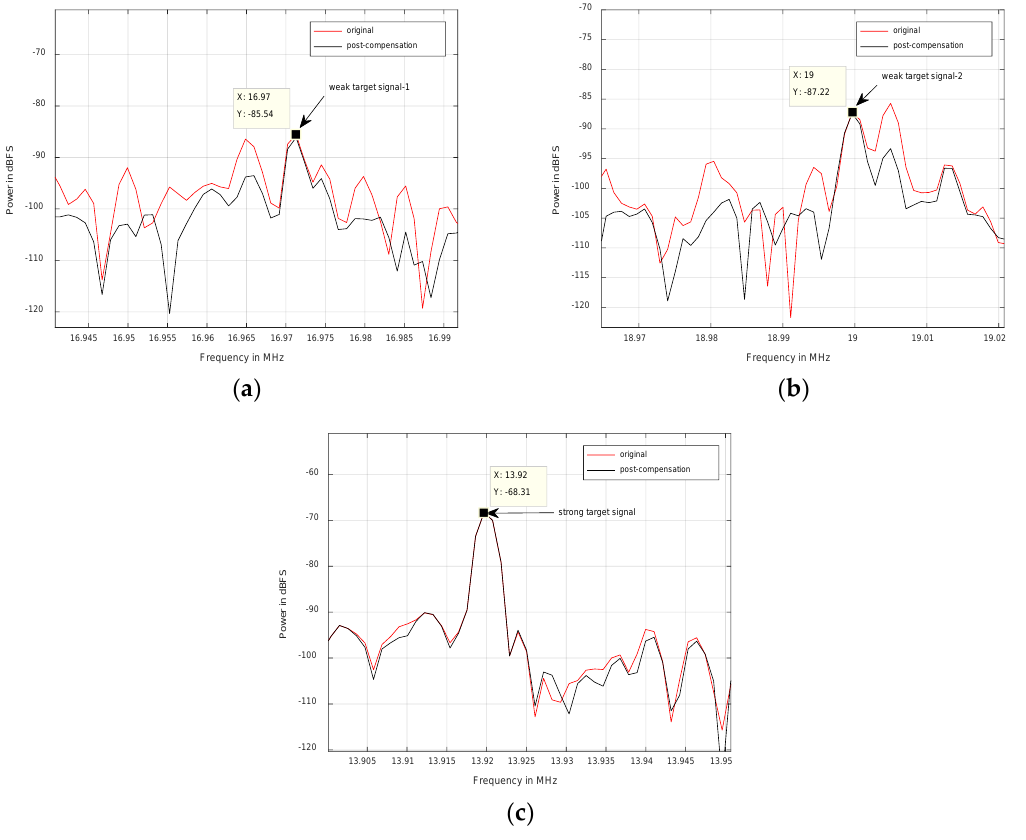
Figure 10. Power spectrum comparison between the original and post-compensation of three target signals in the first channel: ( a ) weak target signal-1; ( b ) weak target signal-2; ( c ) strong target signal.